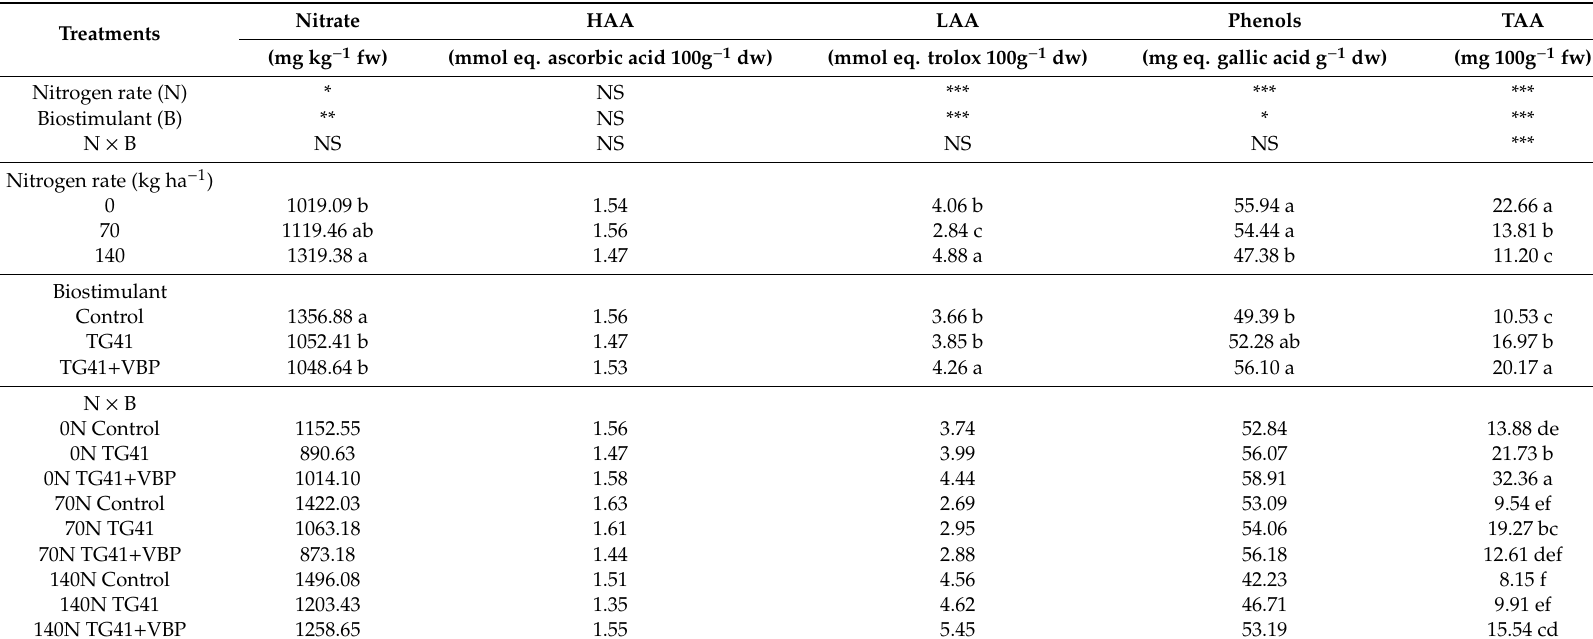
Table 4. Nitrate content, hydrophilic (HAA), and lipophilic (LAA) antioxidants activities, total phenols and total ascorbic acid (TAA) content of greenhouse Romaine lettuce at time of harvest in relation to N fertilization level (0N = 0 kg ha − 1 , 70N = 70 kg ha − 1 , 140N = 140 kg ha − 1 ) and biostimulant application (Untreated =